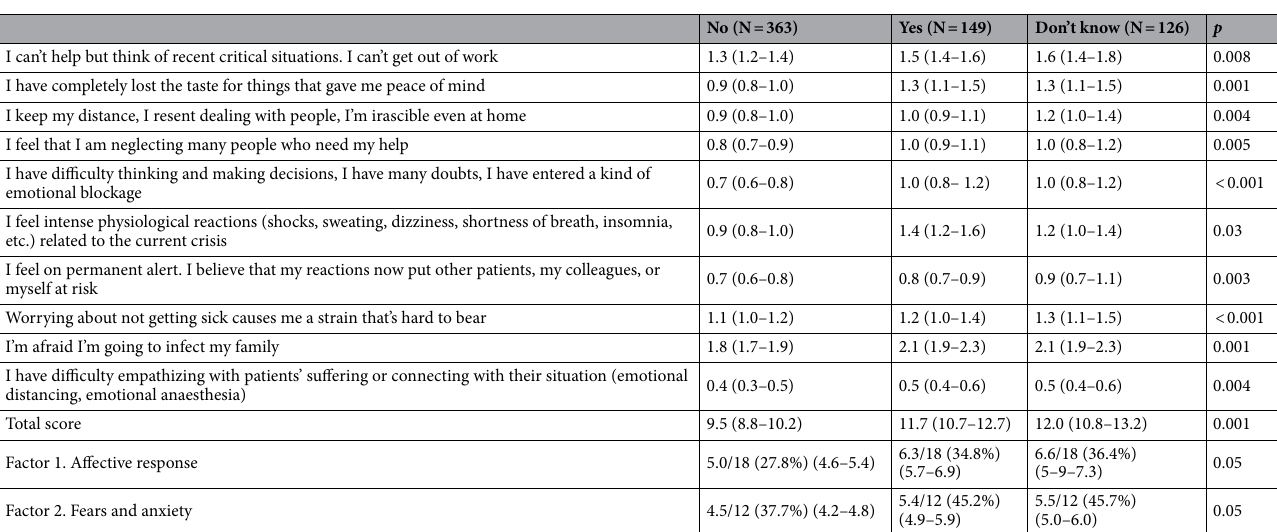
Table 7. Differences in the level of acute stress depending on whether the professional was infected. The Kruskal–Wallis test was performed for the comparison between groups ( p < 0.05). Scores from 0 to 3 points on each of the items on the scale. Scores from 0 to 30 in total on the scale. Scores from 0 to 18 in factor 1. Scores from 0 to 12 in factor